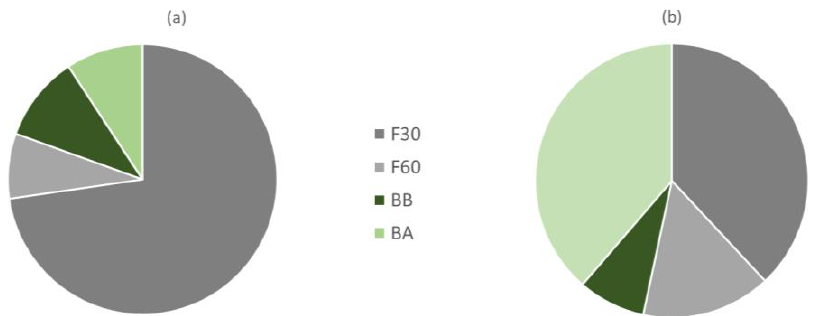
Figure 2. Proportion of total phenols ( a ) and antioxidant activity ( b ) associated with each of the phenol fractions extracted (codes according to Section 2.2).